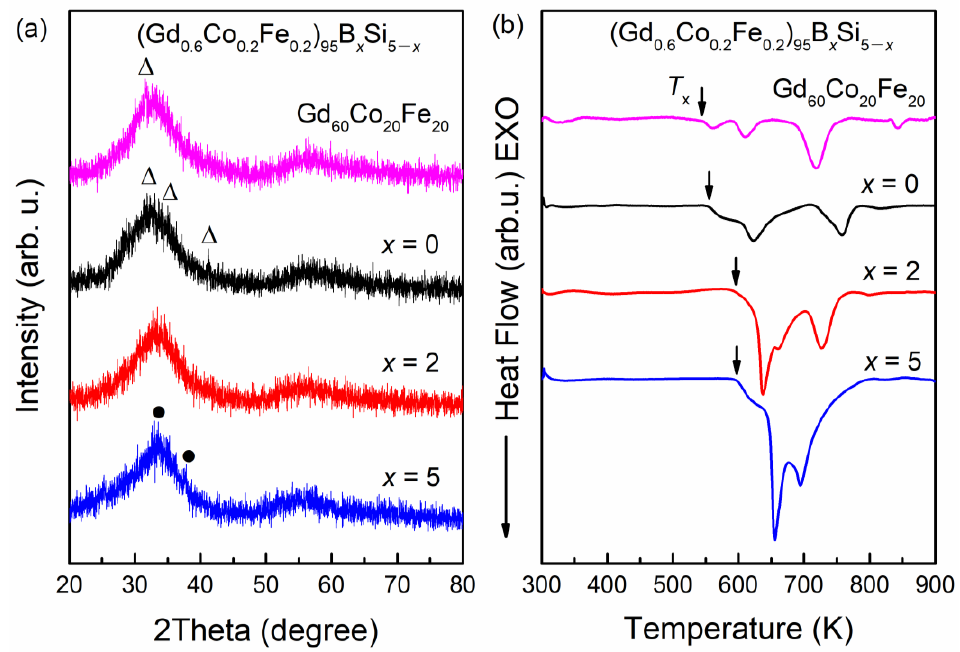
Figure 1. ( a ) XRD patterns and ( b ) DSC curves of the Gd 60 Co 20 Fe 20 and (Gd 0.6 Co 0.2 Fe 0.2 ) 95 B x Si 5 − x ( x = 0, 2, 5) as-spun ribbons. ( x = 0, 2, 5) as-spun